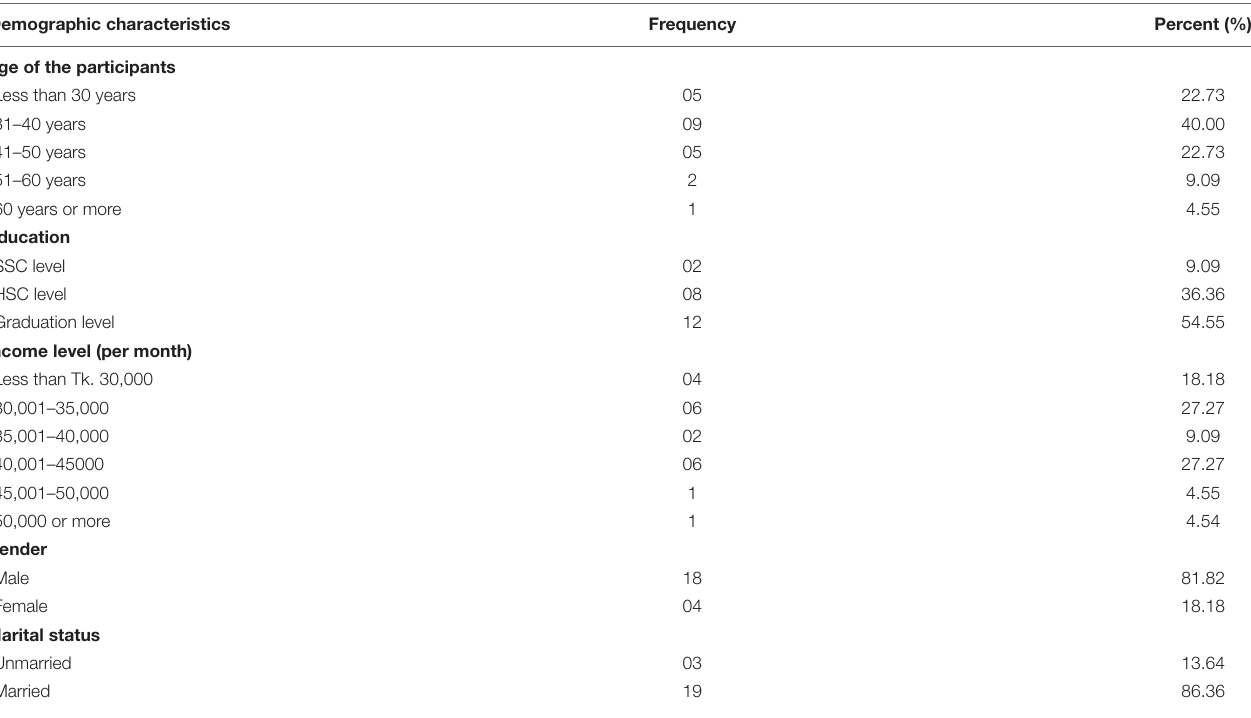
TABLE A2 | Profile of the